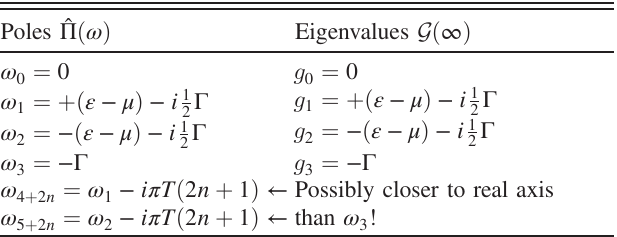
TABLE II. Resonant level model, n ¼ 0 ; 1 ; 2 ; …